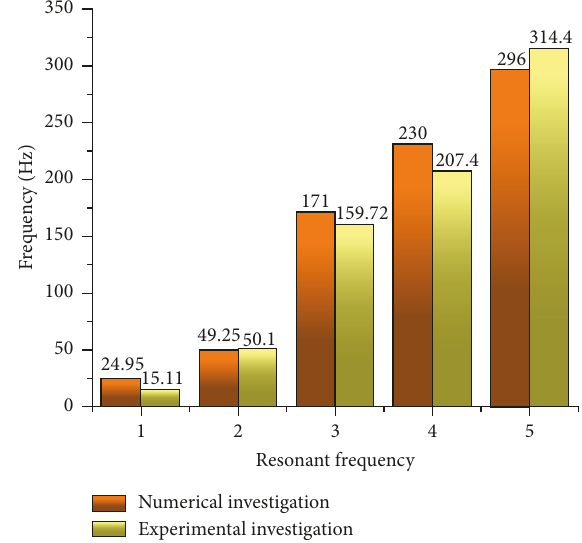
Figure 10: Comparison of the resonance frequencies.